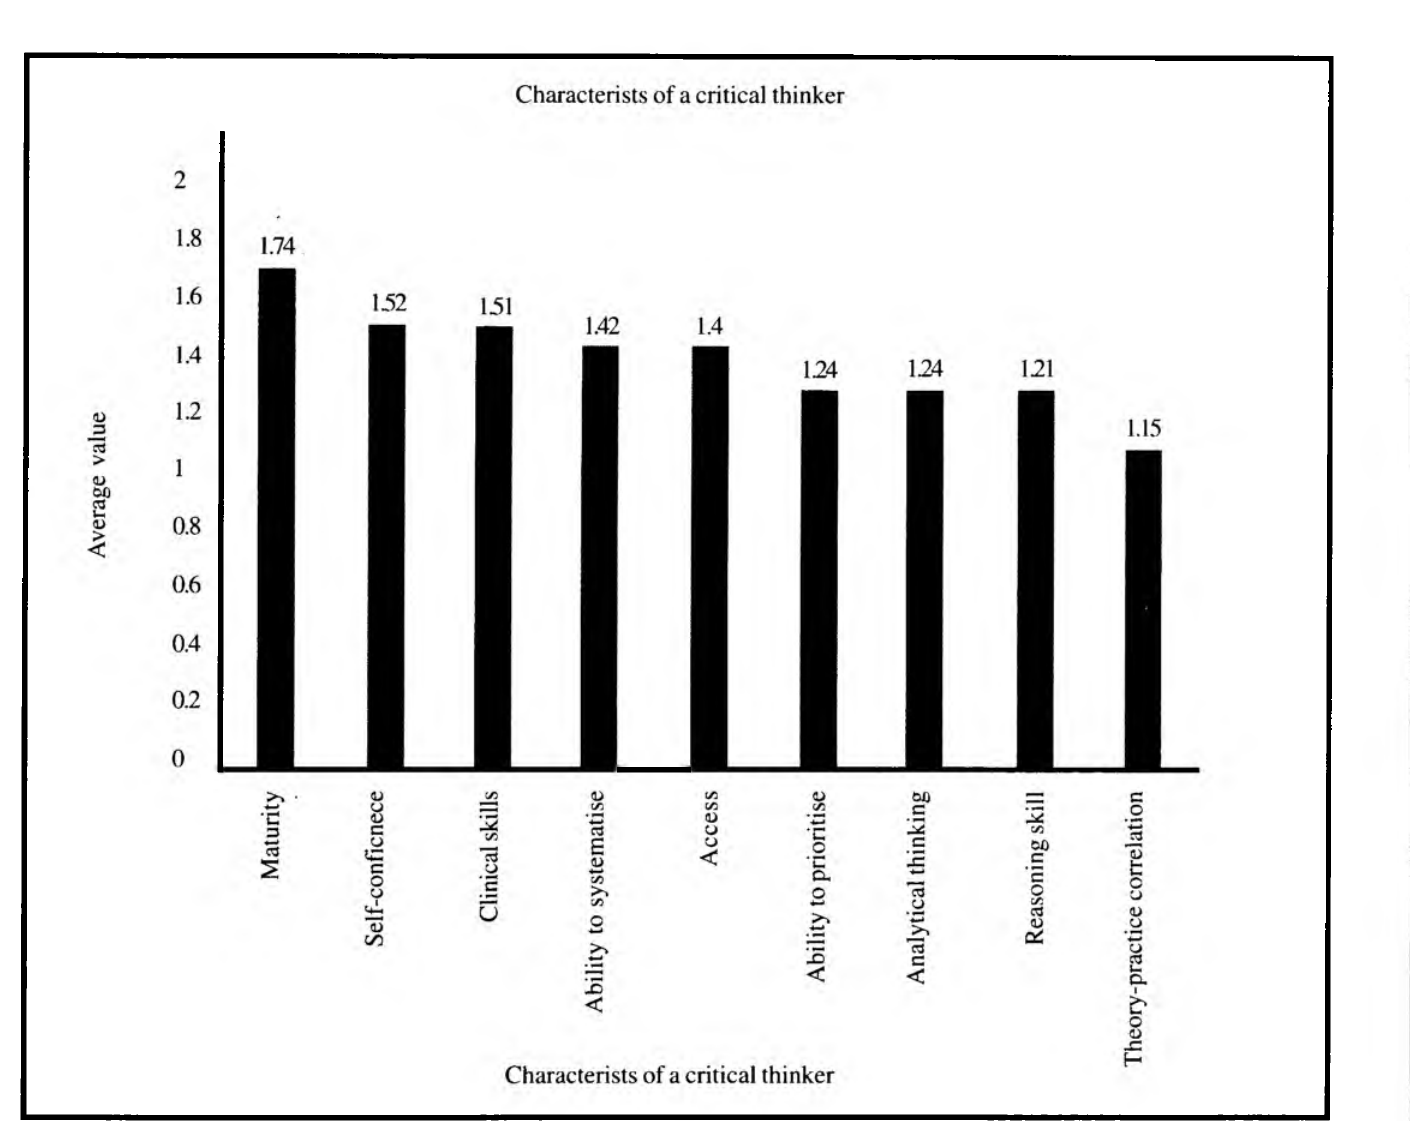
Figure 1: Column graph indicating the values respondents attached to the characteristics of a critical